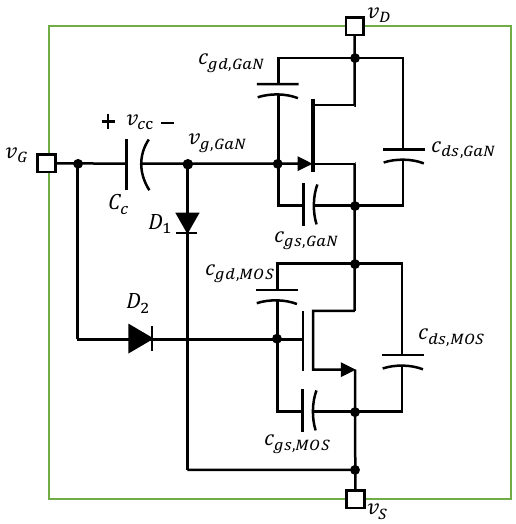
Figure 6. Type 2A — GaN-switching cascode GaN HEMT power module. Figure 6. Type 2A—GaN-switching cascode GaN HEMT power